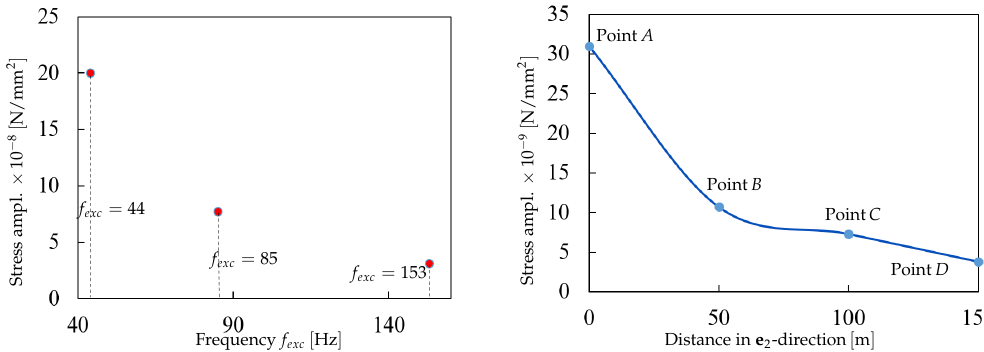
Figure 11. Illustration of the maximum reached amplitude of tr ( σ S ) at point A for the three different excitation amplitudes f exc ( left ). Illustration of attenuation of the maximum amplitude of tr ( σ S ) as getting far from the point of excitation for f exc =153Hz and in the steady-state ( right